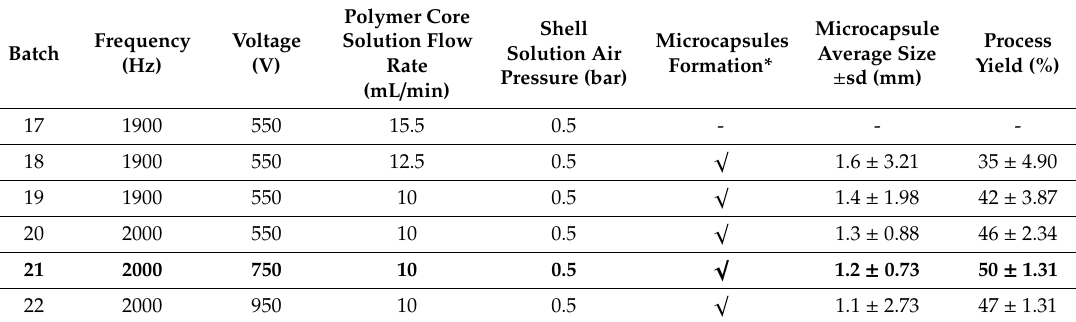
Table 3. Results of process parameters tested for microcapsules